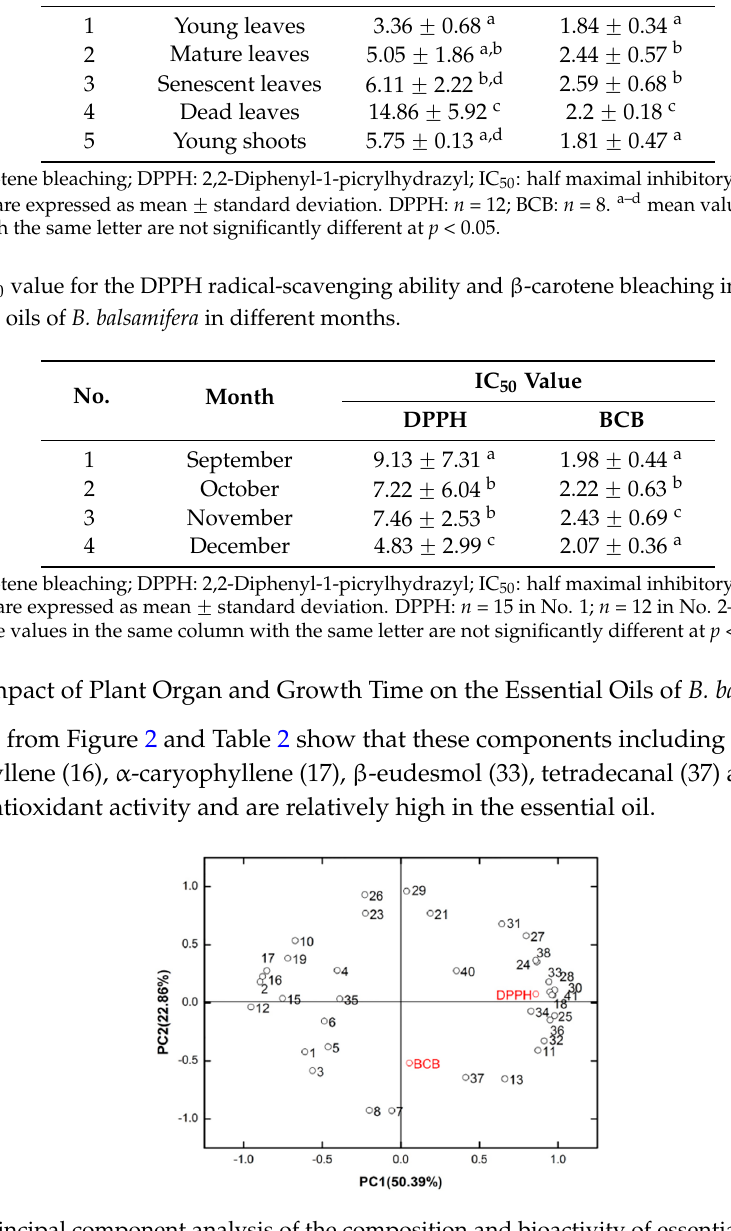
Figure 2. Principal component analysis of the composition and bioactivity of essential oils from the harvest B. balsamifera plants in different months and in different plant organs. The plane contains 73.24%. Numbers represented in the plane correspond to the compounds reported in Table 2.